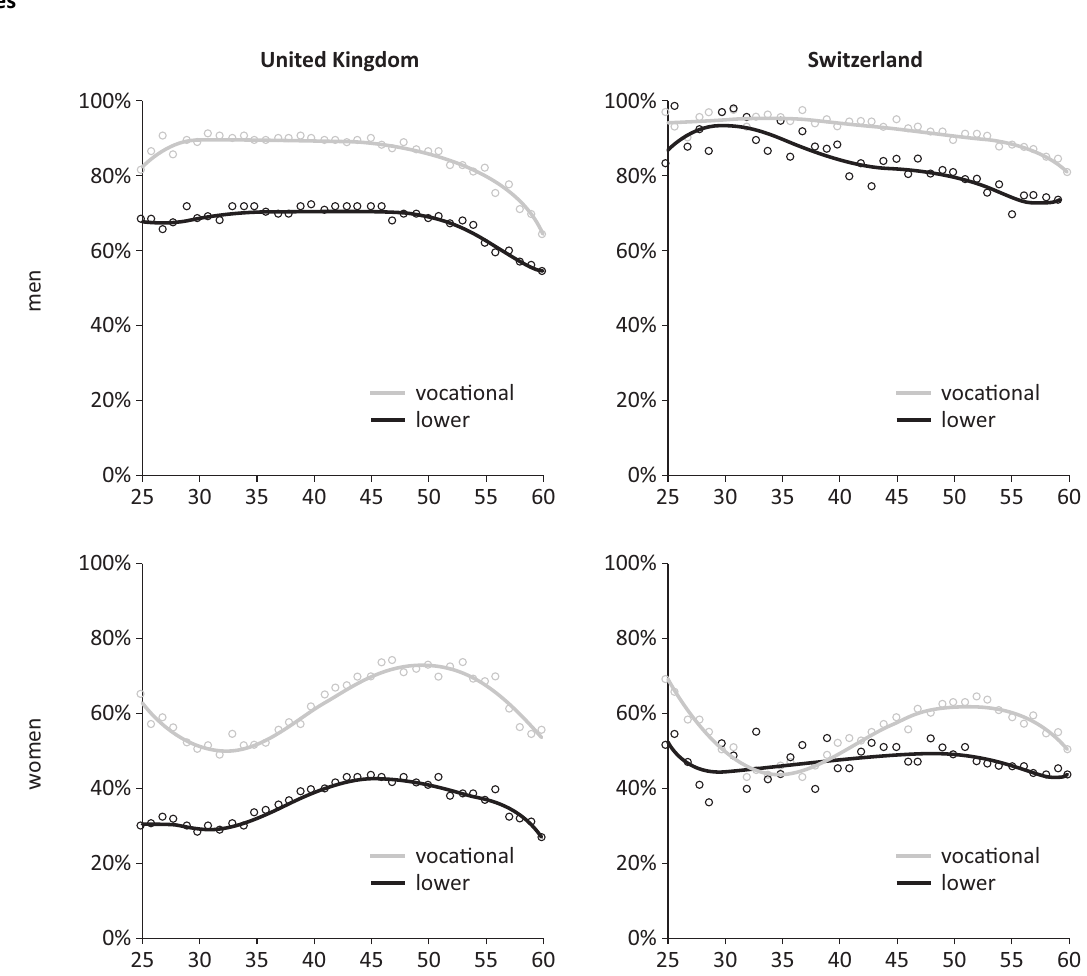
Figure A1. Employment rate (minimum 20 hours per week) for men and women by level of education: upper-secondary vocationaleducation( vocational )and compulsory school levelor lower( lower ). Source:UK Labour